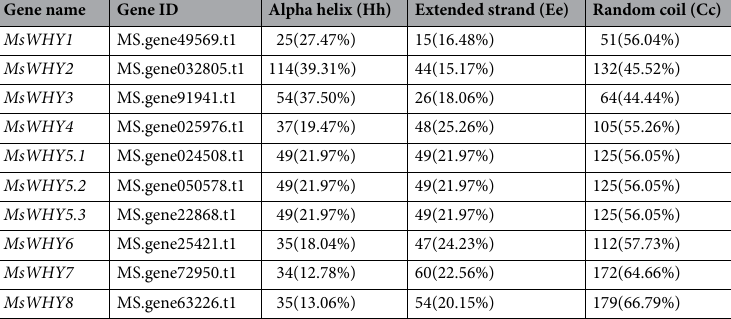
Table 2. Prediction of Whirly protein secondary structure in